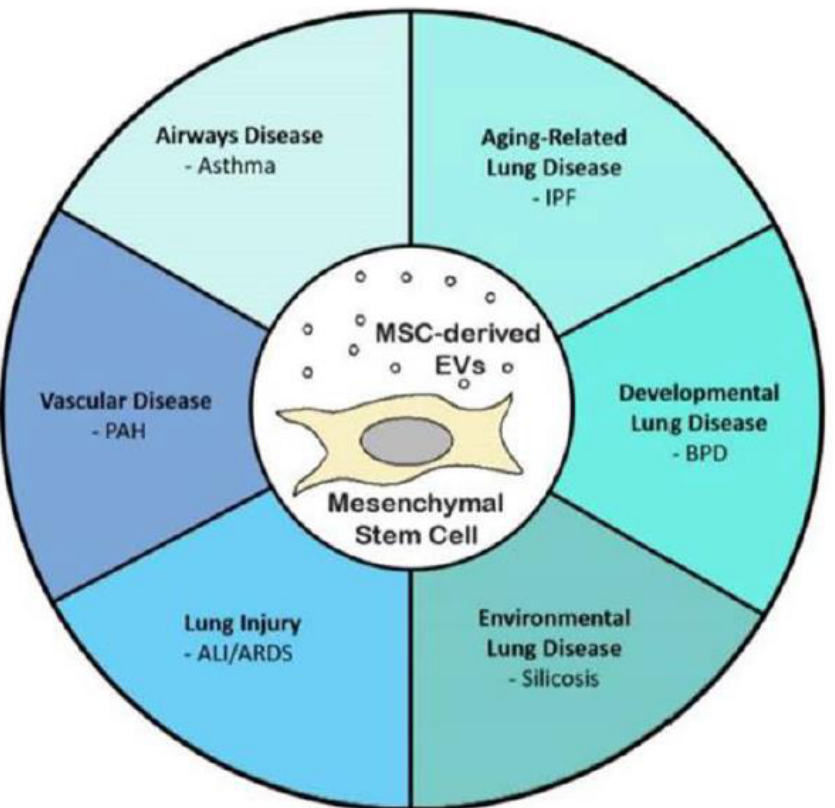
Figure 5. MSC-EVs for potential therapeutics for lung diseases. Reprinted from [69].